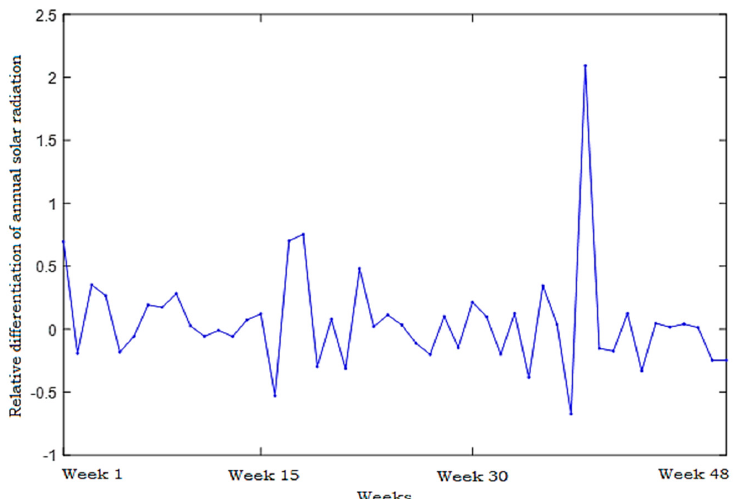
Figure 21. Relative differentiation of annual solar radiation considering weekly radiation averages. Table 10. Order and coefficients of ARMA (2,1). ARMA (p,q) Order